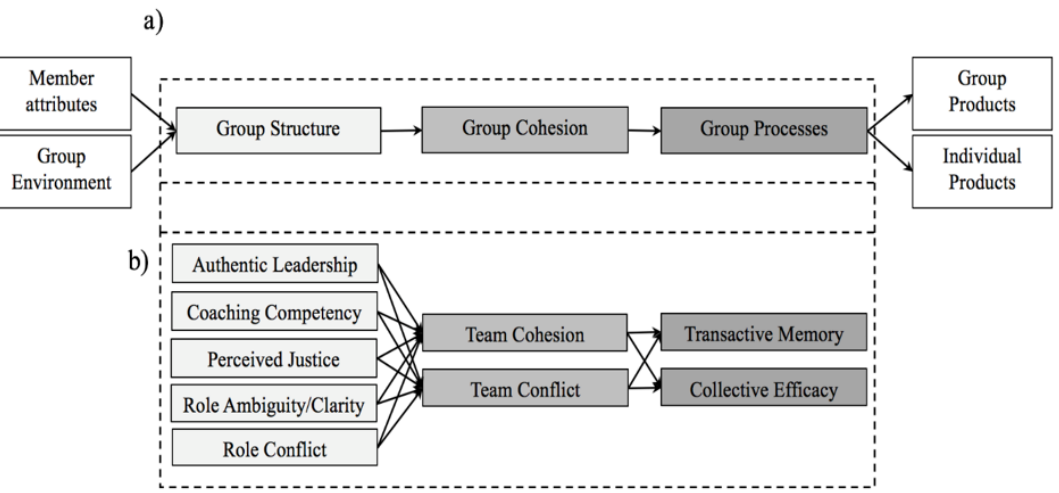
Figure 1. ( a ) A conceptual framework for the study of sports teams developed by Carron and Eys [7]. b ) Proposed model of team dynamics in sports.